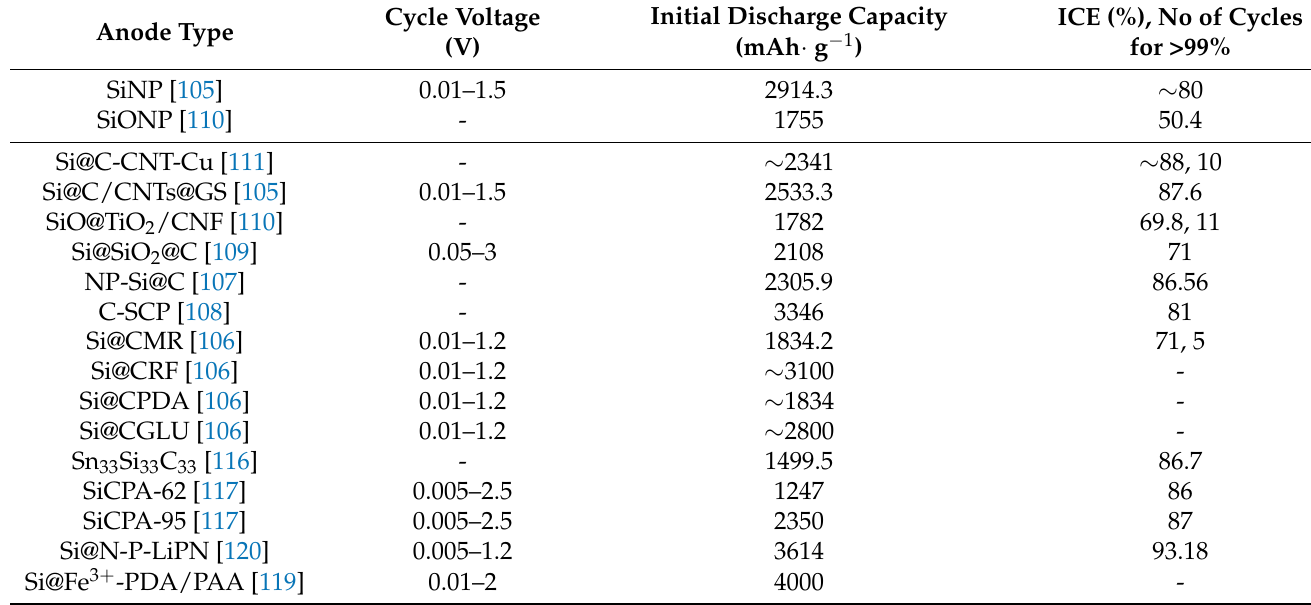
Table 5. Composite Si anodes proposed in recent years: cycle voltage, initial discharge capacity, and ICE